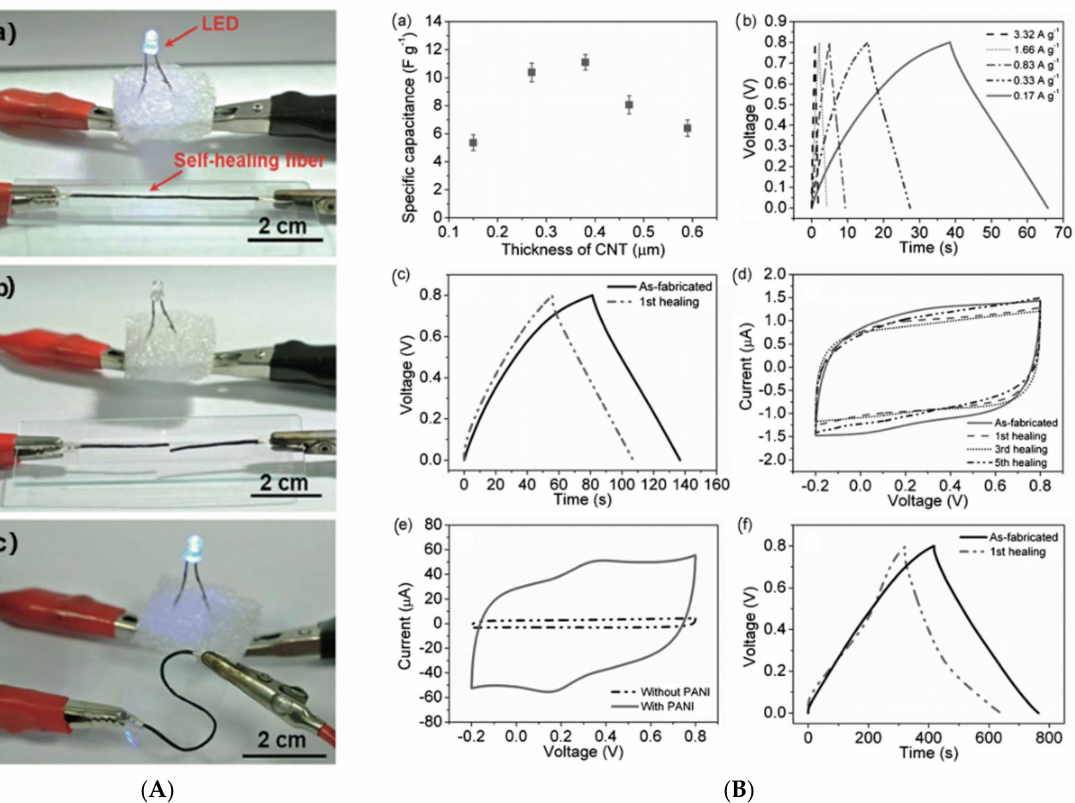
Figure 23. ( A ): ( a – c ) Photographs of a self-healing polymeric fiber (SHP) serving as a conducting wire to power a LED before breaking, after breaking, and after healing, including being bent. The voltage was set at 3.2 V. ( B ): ( a ) Dependence of the specific capacitance on the thickness of the aligned-CNT film. ( b ) GCD curves of a wire-shaped supercapacitor with increasing current densities at a CNT thickness of 0.38 µ m. ( c ) GCD curves before breaking and after healing at a current density of 0.08 A · g − 1 . ( d ) CV curves at a scan rate of 50 mV · s − 1 after 1, 3, and 5 healing cycles. ( e ) CV curves of wire-shaped supercapacitors based on aligned CNT/SHP fibers before and after incorporating PANI. ( f ) GCD curves for a PANI-incorporated SC before breaking and after healing at a current density of 0.17 A · g − 1 . Reprinted with permission from [99].